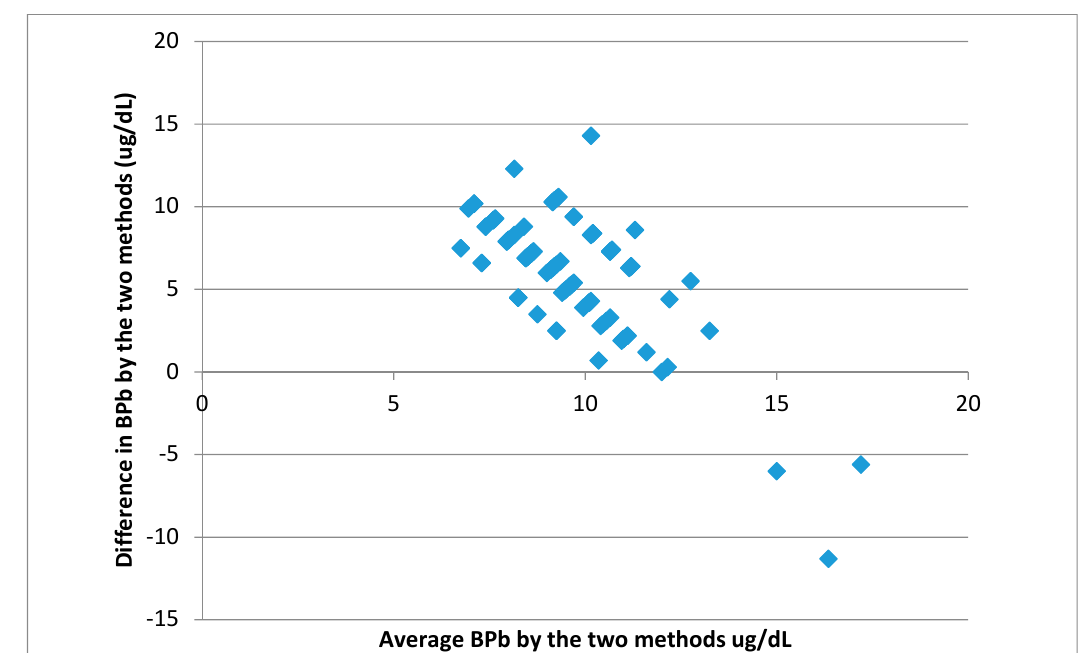
Figure 2. A plot of the average of the measured and predicted BPb against the differences between predicted and measured BPb values (for 50% food bioavailability).